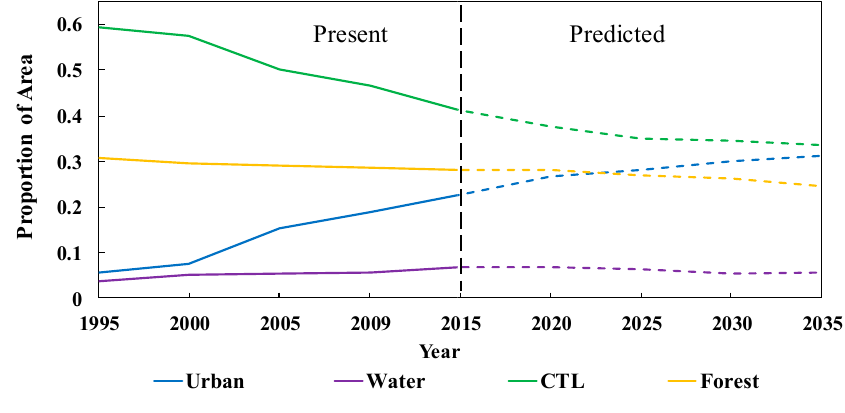
Figure 9. Area proportion of land use area from 1995 to